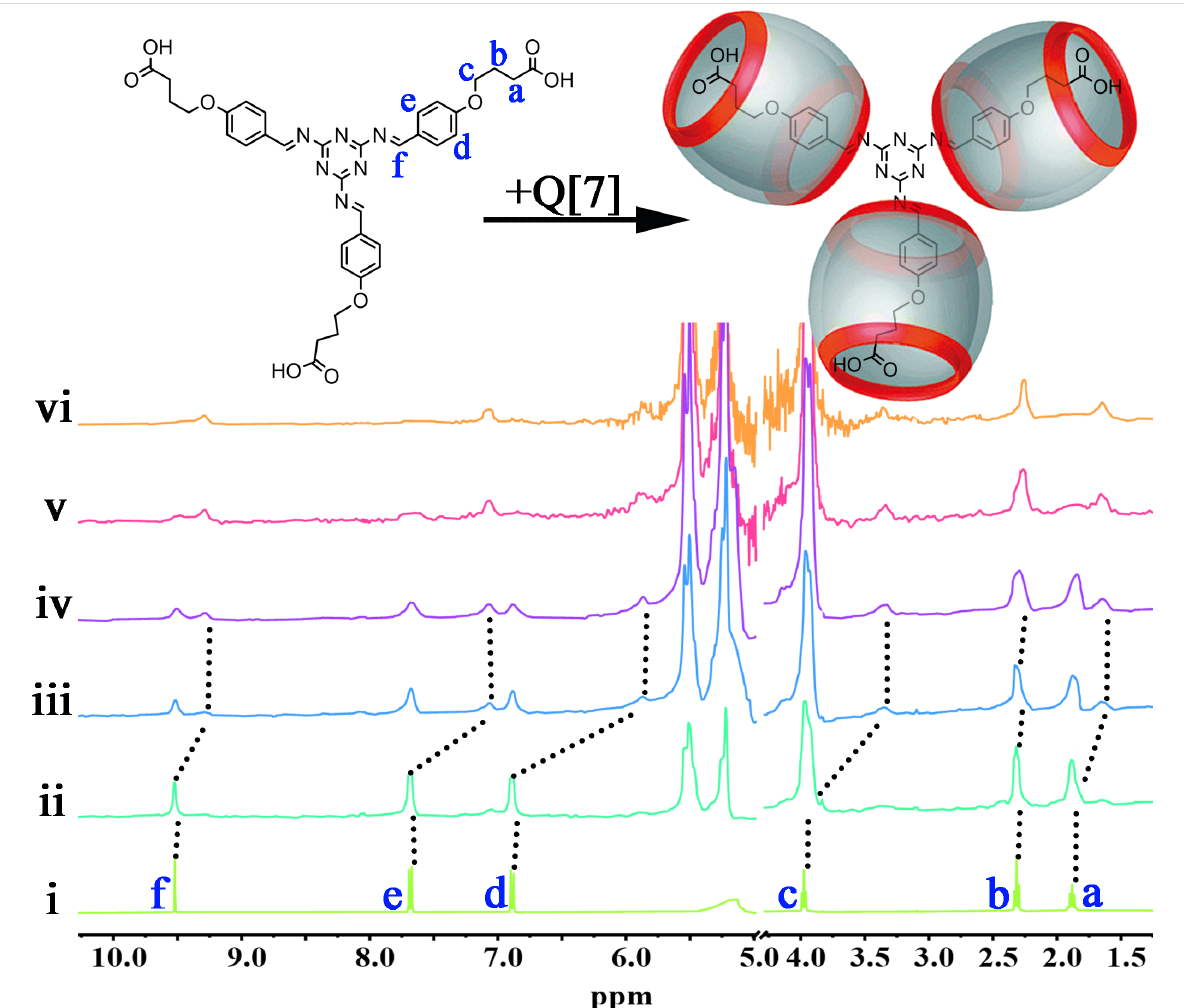
Figure 2: The 1 H NMR titration of TBT (1 mM) with an increasing amount of Q[7] from 0 (i), 0.1 (ii), 0.5 (iii), 1.0 (iv), 2.0 (v) to 3.0 equiv (vi) in D 2 O.